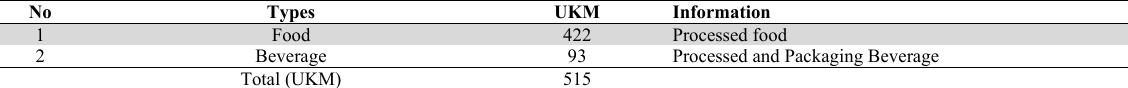
Food and Beverage Small and Medium